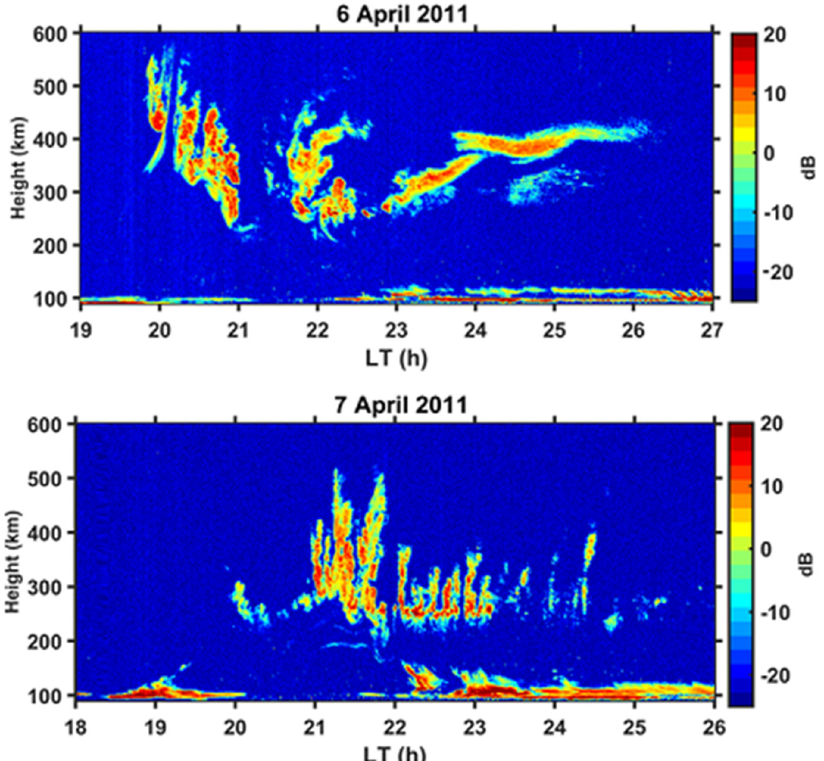
Figure 2. RTI maps obtained from MST radar observations at Gadanki on two consecutive nights: 6 April 2011 ( top panel ) and 7 April 2011 ( bottom panel ) show that EPBs that developed on the bottom side of the equatorial F region after sunset, starting with different initial perturbations on these two days, also evolved differently with time and gave rise to plume structures with entirely different characteristics. The plume structures that appear in the RTI map are images of a succession of EPB structures that drift into the radar’s field of view at different times.